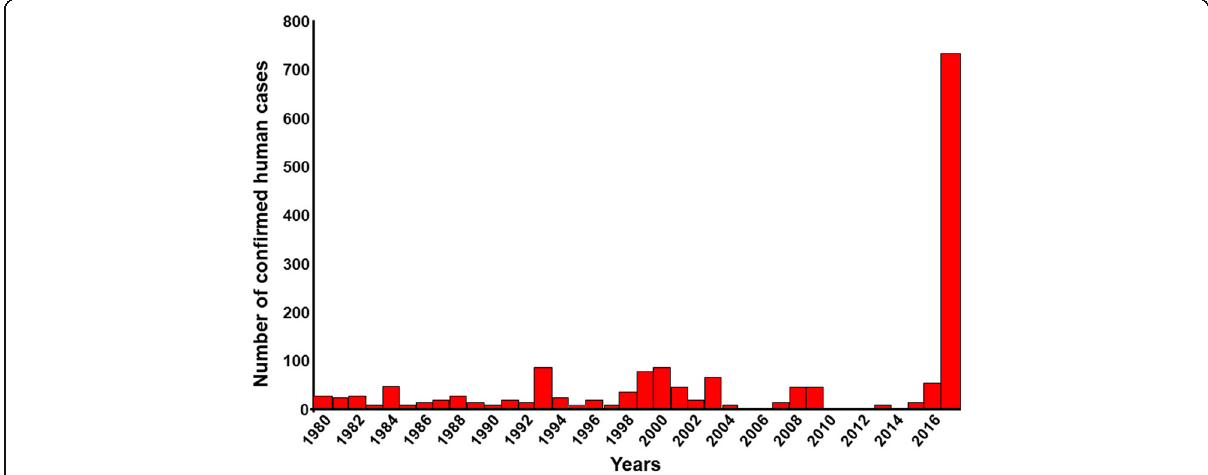
Fig. 1 Confirmed human yellow fever cases in Brazil between 1980 and 2017 (from Sinan; GT-Arbo/UVTV/CGDT/DEVIT/SVS/MS